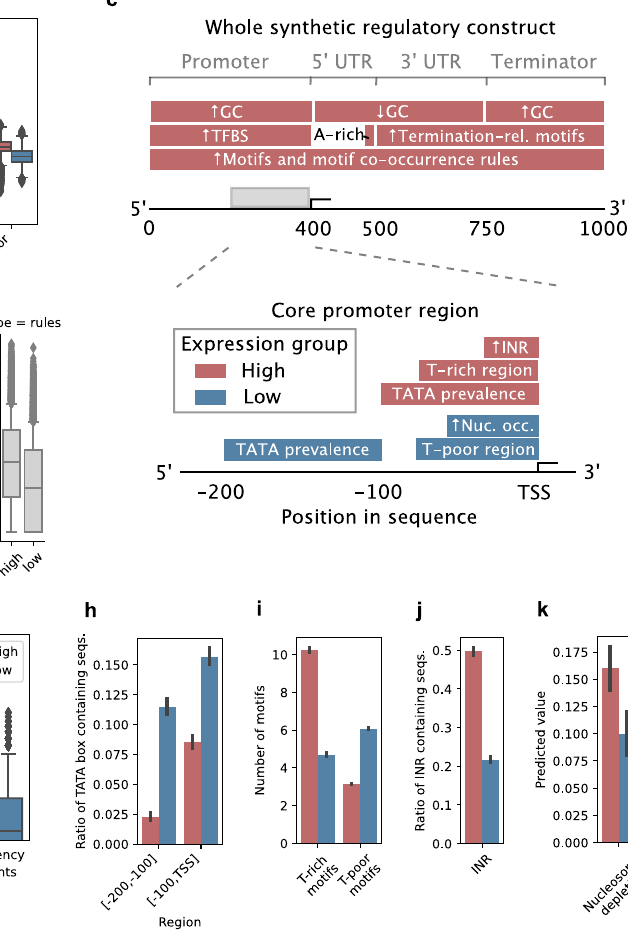
( n =10,000 each). f Amount of adenines conserved in 5, 10, and 15bp 5 ′ UTRs upstream of the start codon 52 ( n =10,000 each). g Number of termination-related elements, including Poly-A/T, positioning and ef fi ciency motifs 27,54,65 ( n =10,000 each). h ProportionofsequencescarryingaconservedTATAbox 50 inthedistaland proximal parts of the core promoter region 51 ( n =10,000 each) (Fig. 5c). i Amount of T-rich and T-poor motifs in the region up to 75bp upstream of the TSS 51,68 ( n =10,000 each). j Proportion of mammalian-type INR motifs in the region up to 30bp upstream of the TSS 69 ( n =10,000 each). k Proportion of predicted nucleo- some depletion 55,56 in the region up to 50bp upstream of the TSS 70,71 ( n =10,000 each). For box plots in b , e – g , boxesdenote interquartile (IQR) ranges, centers mark medians and whiskers extend to 1.5 IQR from the quartiles. For bar plots in h – k , error bars represent 95% con fi dence intervals. Source data are provided as